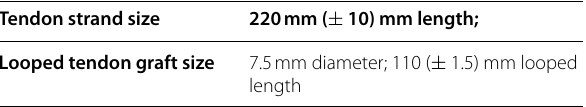
Table 1 Geometric aspects of prepared tendon samples for experiments Tendon strand size